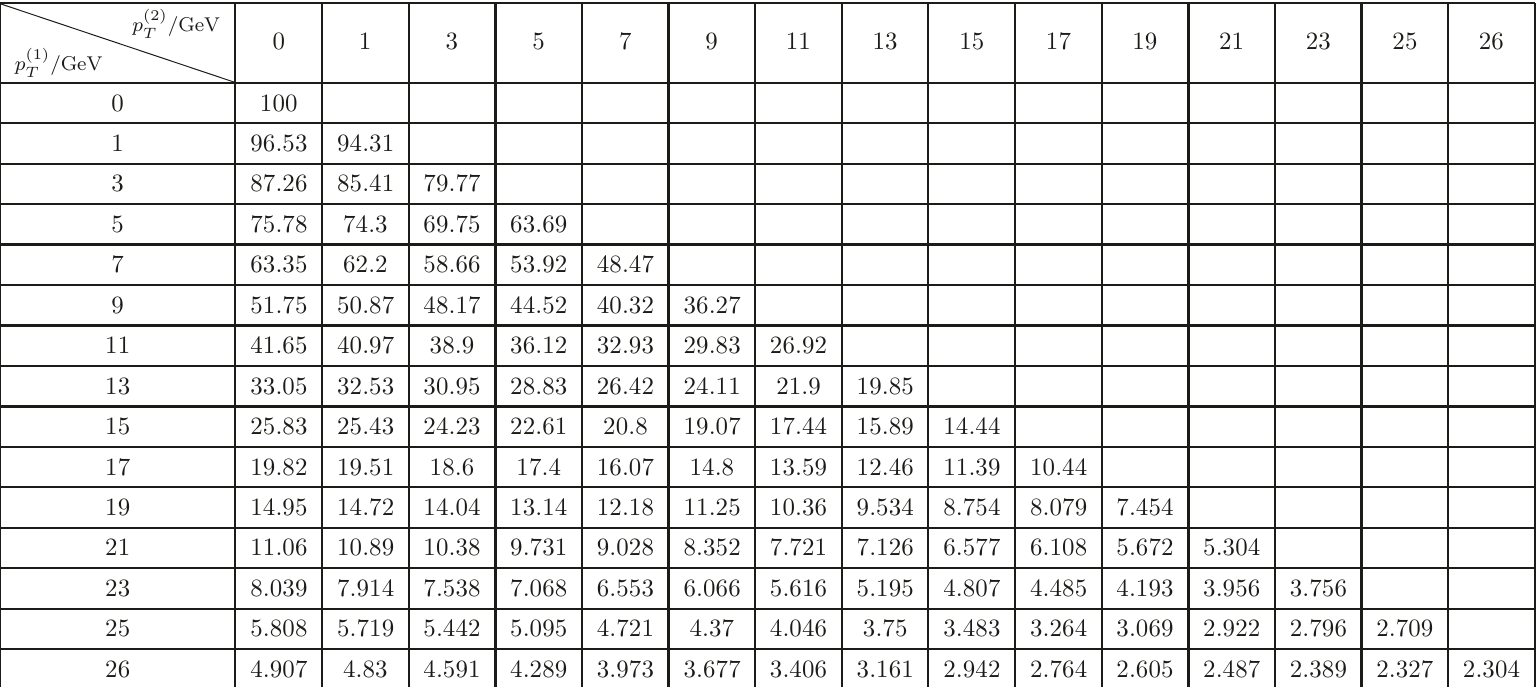
Table 3. Efficiencies (%) of the combined cuts p lead. l T > p (1) in table